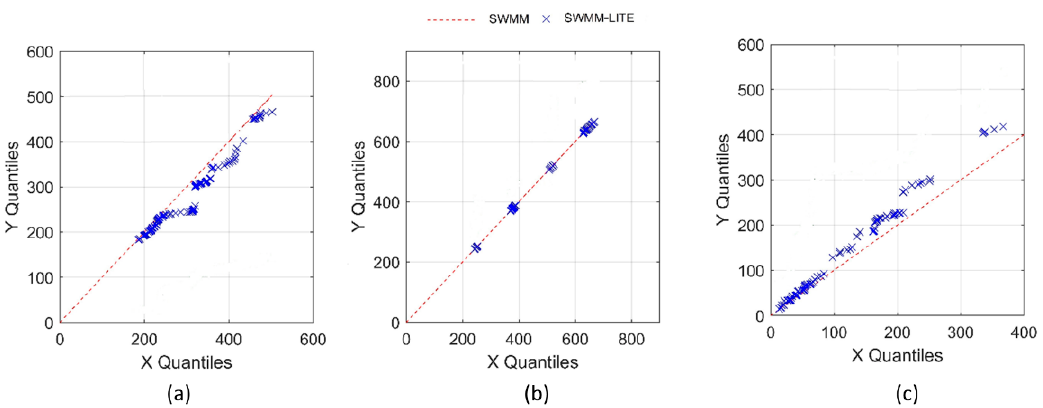
Figure 6. Quantile-quantile chart of simulated models including SWMM and SWMM-LITE; ( a ) total runoff; ( b ) infiltration; and ( c ) evaporation.